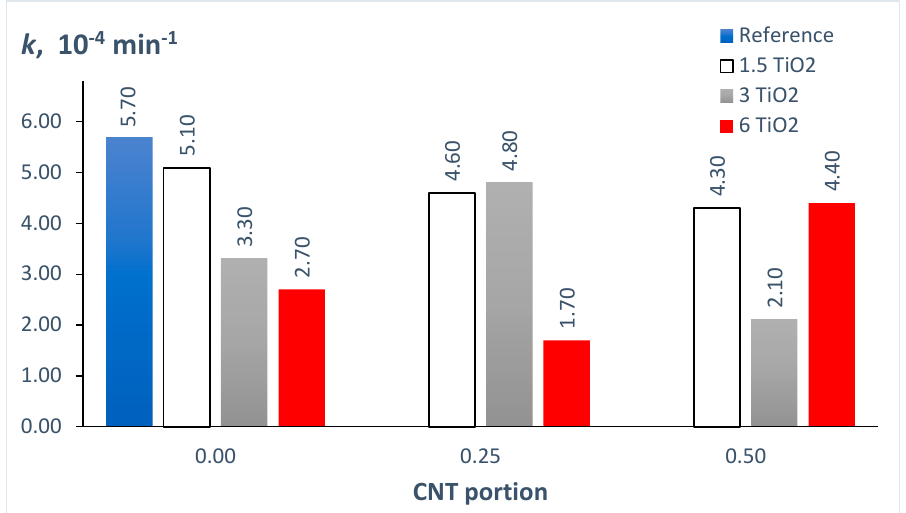
Figure 4. Comparison of amoxicillin decomposition rate constants for different groups of static mix- ers.